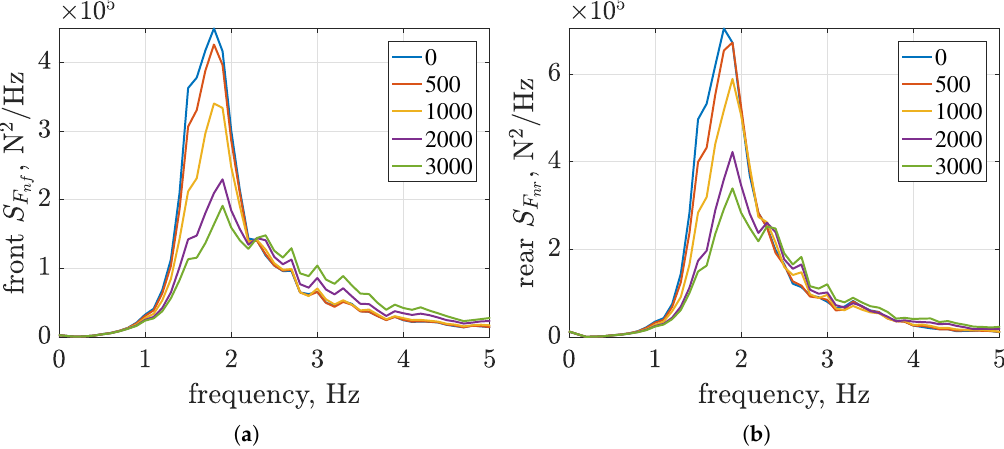
Figure 16. Power spectral density characteristics of wheel normal forces for Skyhook control of the body vibration modes (Skyhook-2DOF) and vehicle longitudinal velocity equal to 5 ms − 1 : ( a ) front wheel, ( b ) rear wheel.